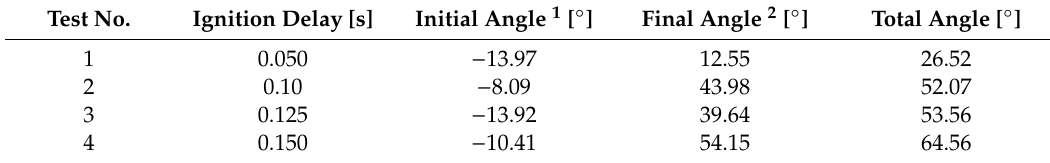
Table 4. Ground tests results.